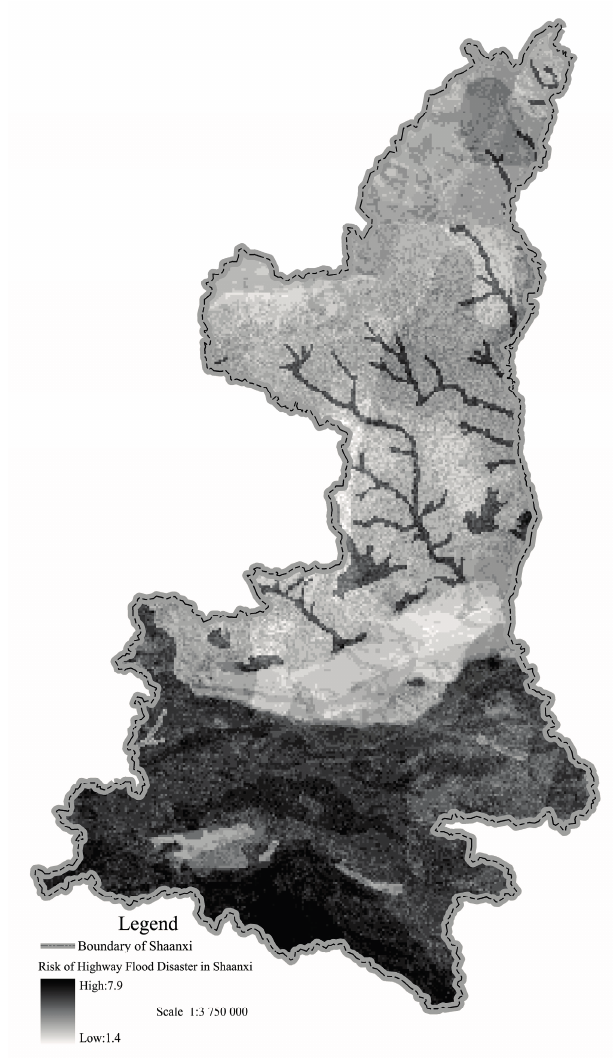
Figure 2. Distribution of highway flood disaster risk in Shaanxi